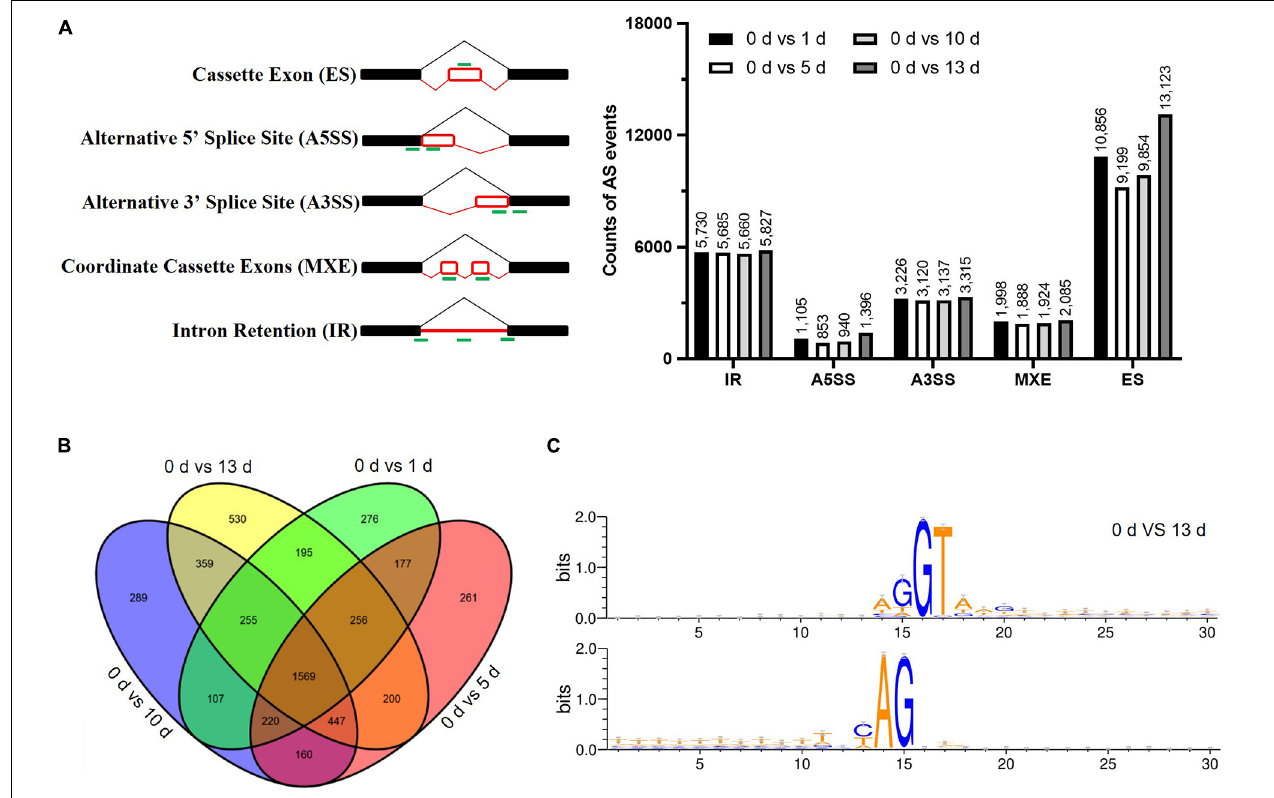
FIGURE 4 | The alternative splicing (AS) profile of date palm was affected by high salinity. (A) The differentially alternative splicing (DAS) events caused by high salinity in date palm. (B) The Venn diagrams of DAS events caused by high salinity for indicated time in date palm. The overlapped region stands for the DAS events caused by different stress treatment. (C) The nucleotide sequences around the alternative 5 (cid:48) SS and 3 (cid:48) SS were shown by Weblogo. The results indicated that these alternative 5 (cid:48) SS and 3 (cid:48) SS were still associated with GU and AG dinucleotides.